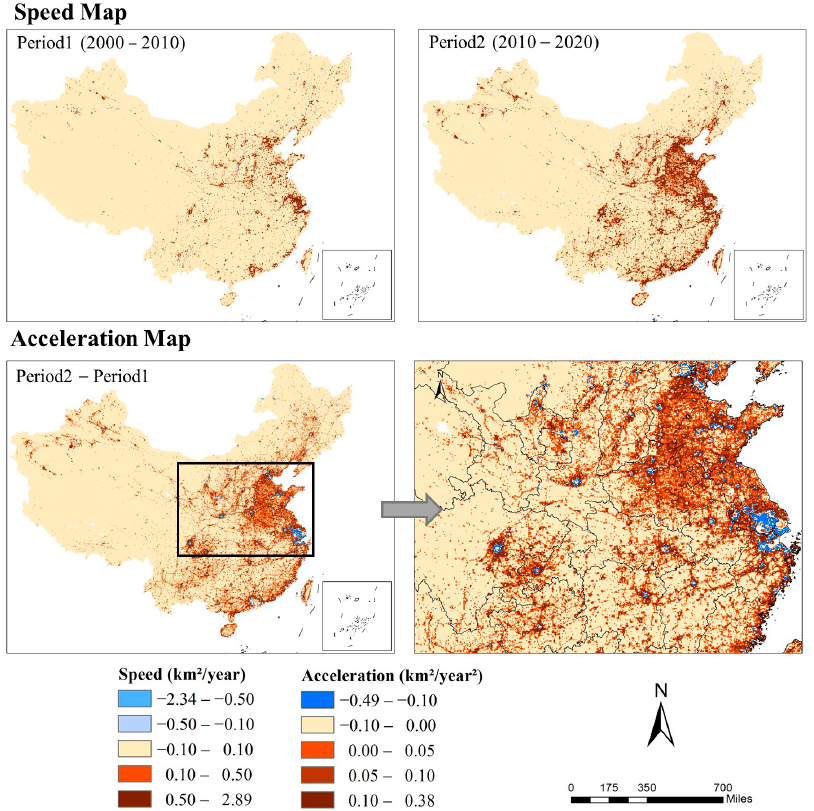
Figure 5. The speed and acceleration maps of NTL in China. The negative value in the speed legend acceleration of NTL represents the speed of NTL reduction, and the negative value of acceleration represents the accel- eration of NTL reduction.